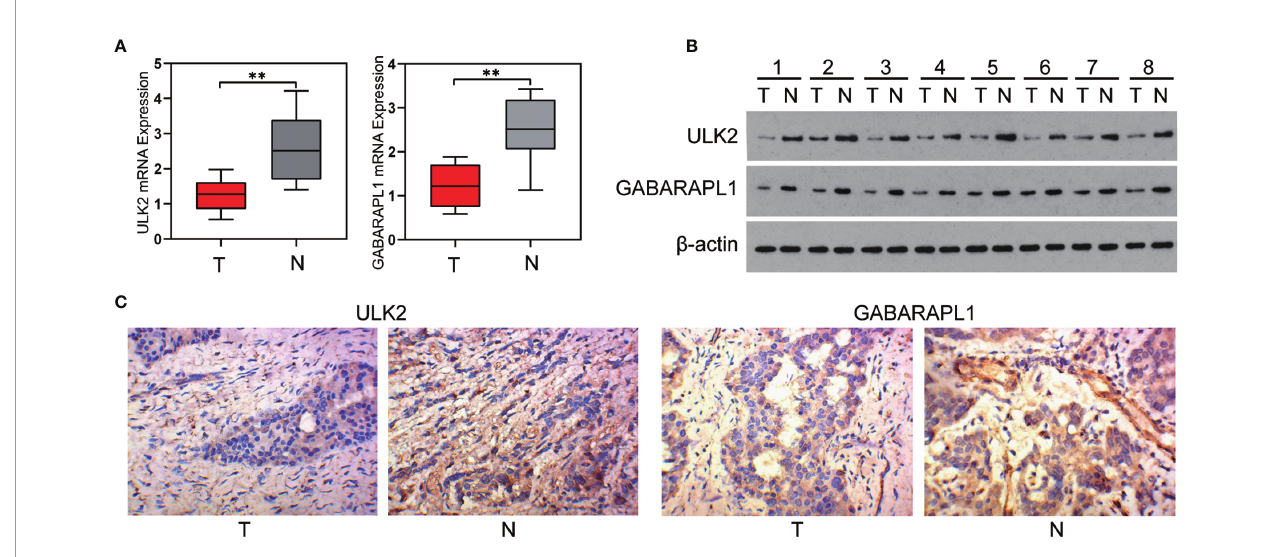
FIGURE 8 | Expression of ULK2 and GABARAPL1 in OC. (A, B) ULK2 and GABARAPL1 expression decreased in OC tissues, compared to the paired paracancerous tissues specimens from 8 patients, determined by qRT-PCR analysis and western blot analysis. (C) Representative immunohistochemical images of ULK2 and GABARAPL1 expression in OC tissues and paracancerous tissues analyzed by IHC (400×). T, tumor; N, paracancerous tissues. **P <